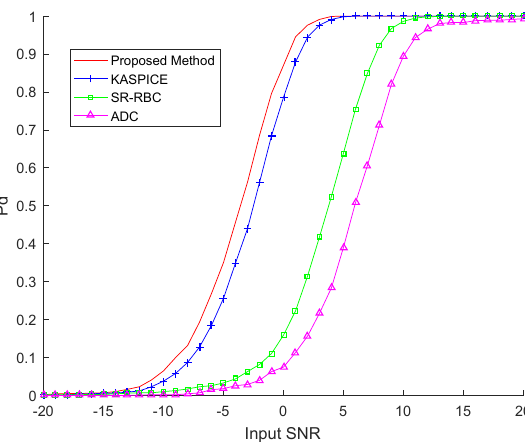
Figure 9. PD versus SNR with different methods.